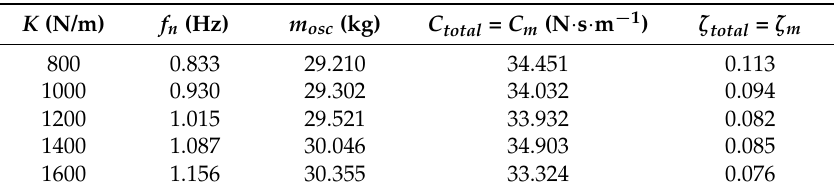
Table 1. Free decay test results by varying